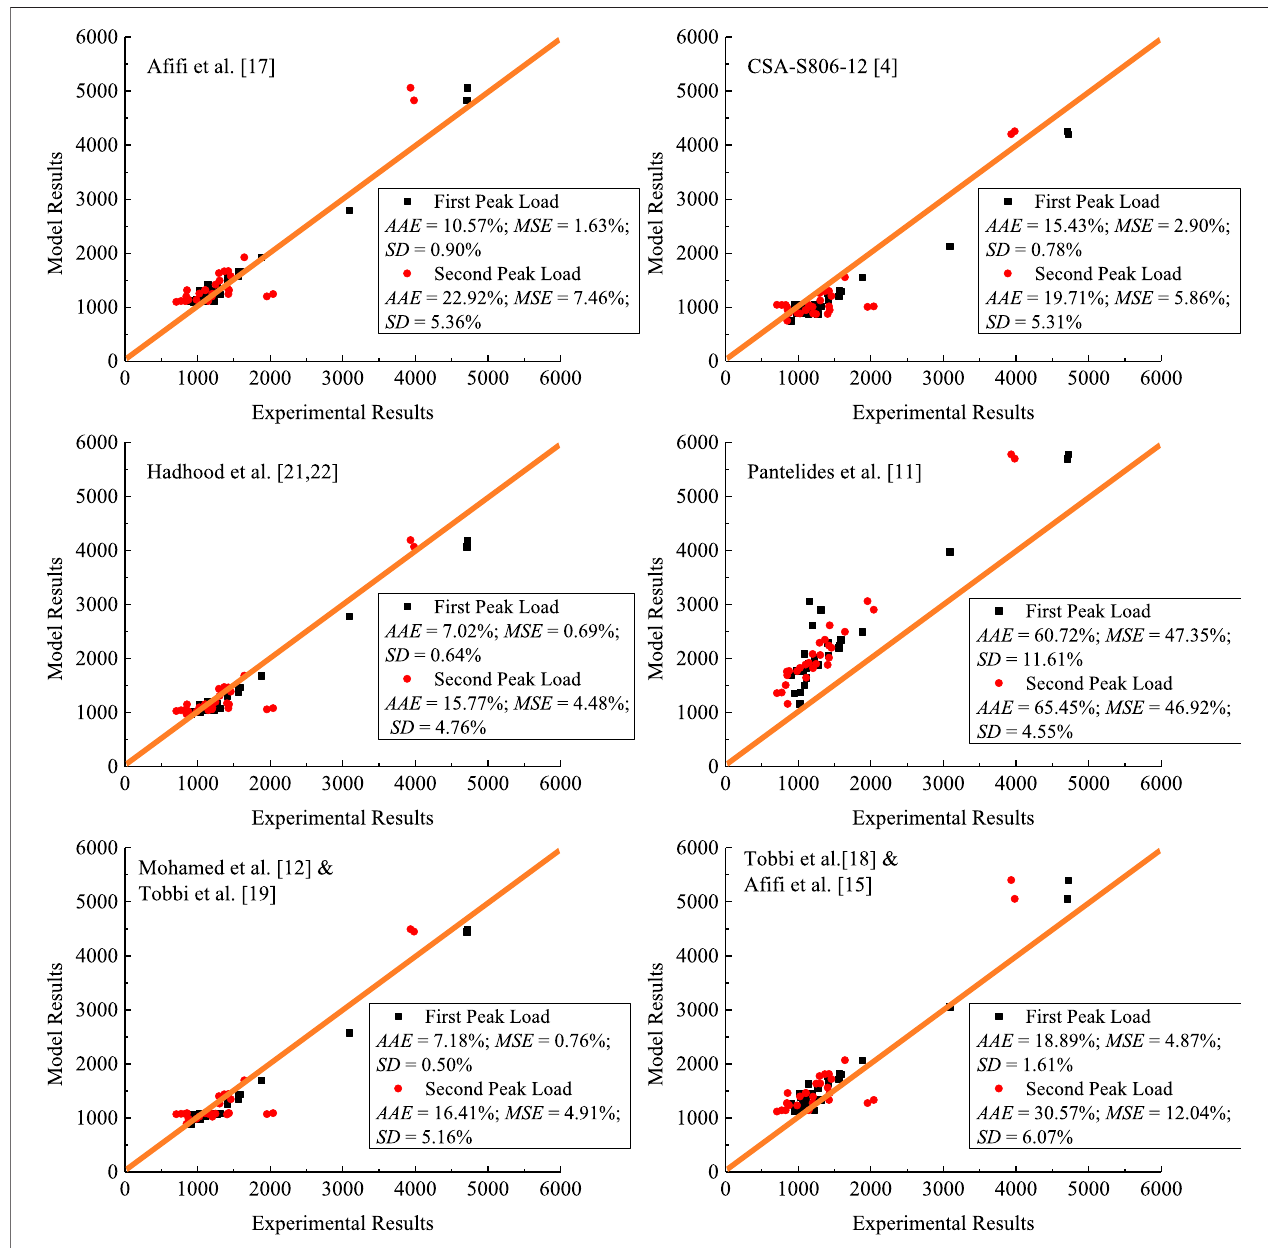
FIGURE 1 | Comparison of experimental and existing model results for the peak and ultimate axial strengths of FRP-RC specimens.